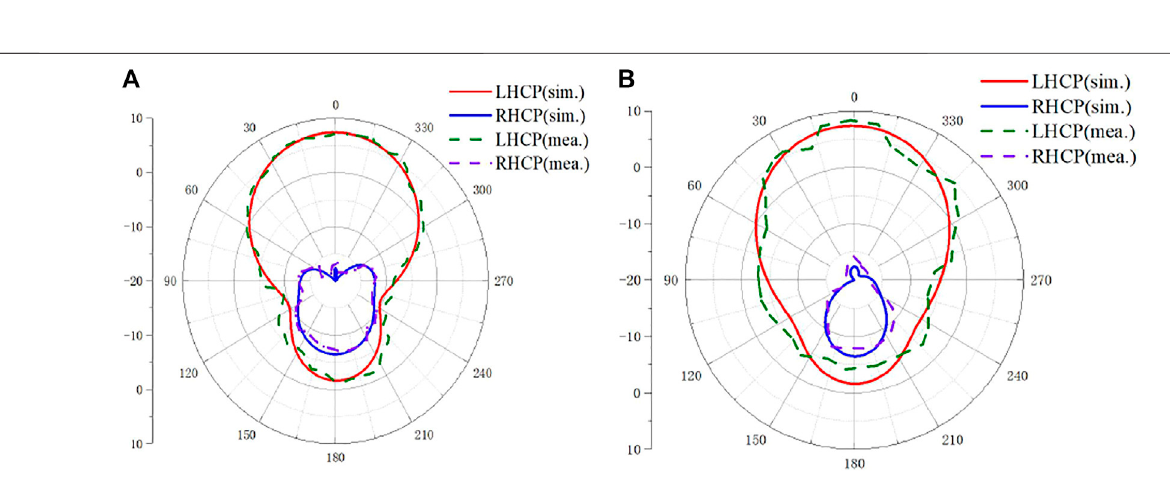
Frontiers in Physics |